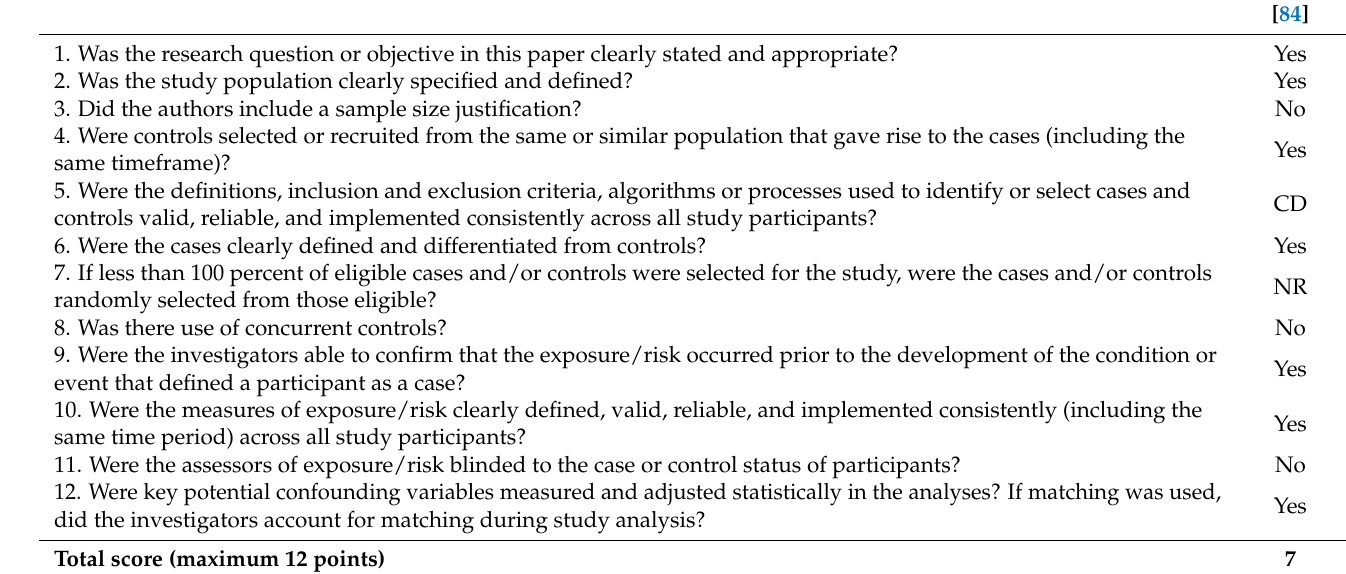
Table 5. Quality assessment of Case-Control Studies.